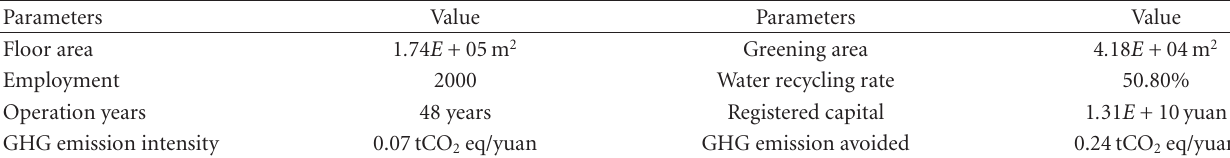
Table 1: Main parameters of the low carbon industrial park.